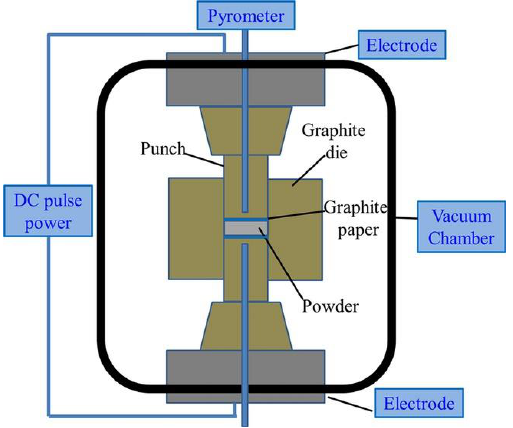
Figure 4. Spark plasma sintering (SPS) process representation, reproduced from [57], with permission from John Wiley and Sons, 2014.